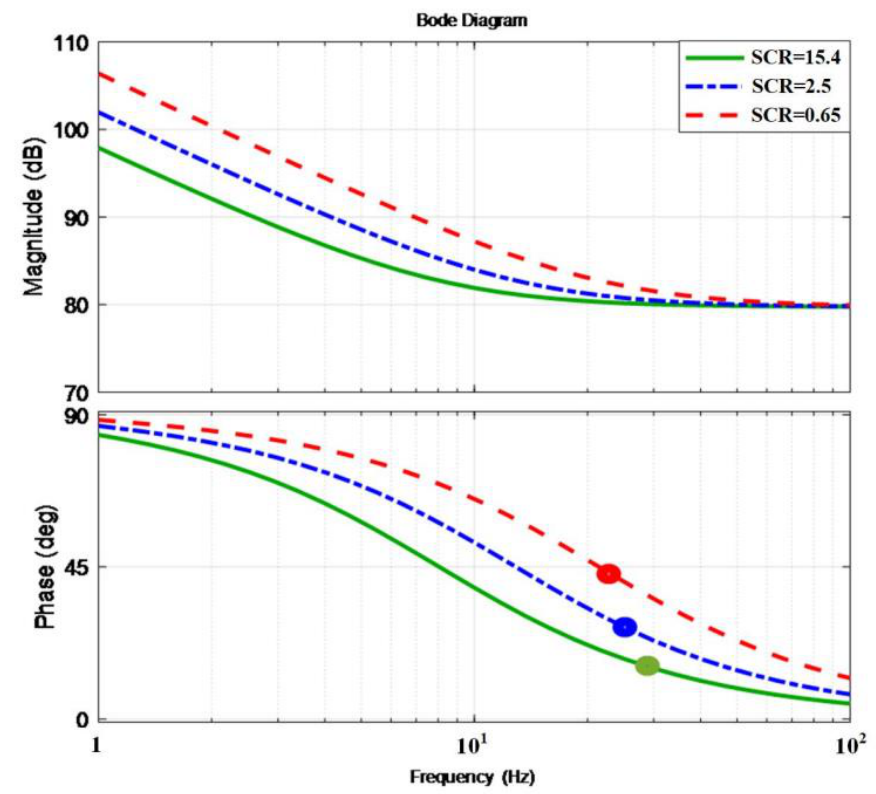
Figure 11. Bode diagram of G 1 ( s ) for different grid strengths.